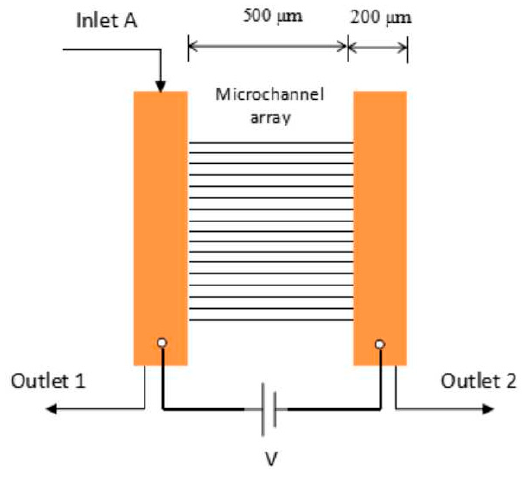
Figure 1. The microchannel electroosmotic system.